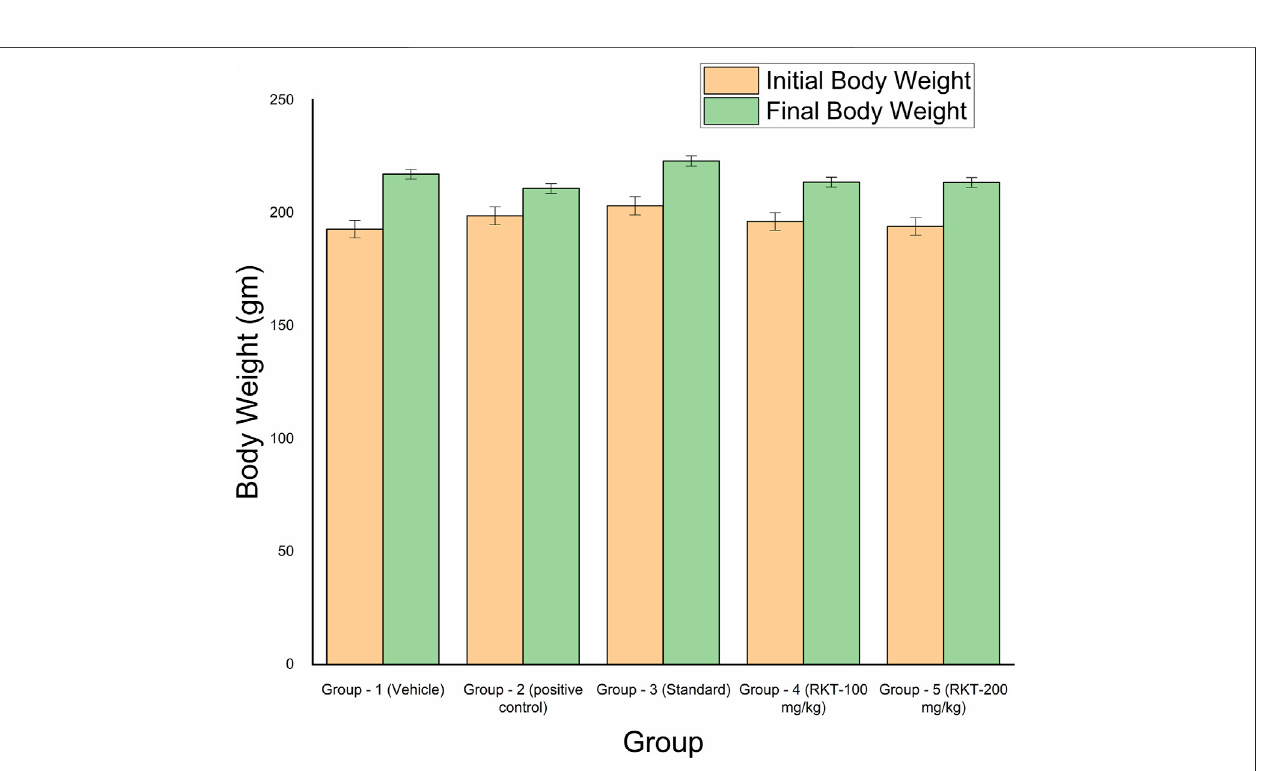
Frontiers in Pharmacology |